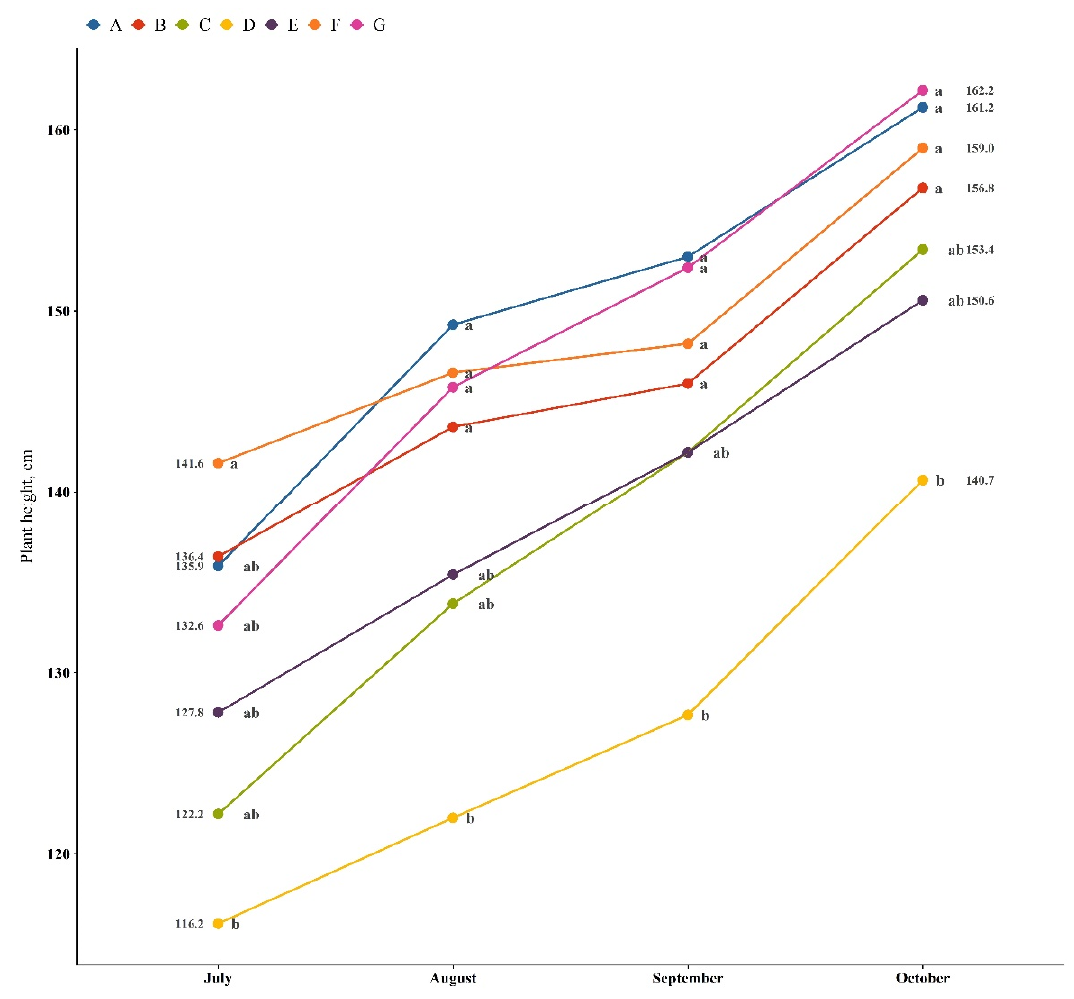
Figure 1. The growth dynamic of M. × giganteus in TEs-contaminated soil supported by PGPB isolates. Different letters indicate the significant difference between treatments.